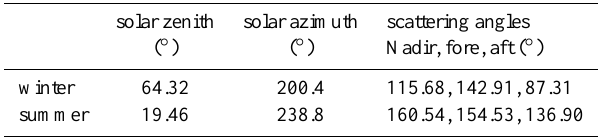
Table 2. Angles used in the simulation scenarios. Azimuth angles for the fore and aft satellite viewing are 180 ◦ and 0 ◦ , respectively (i.e., straight south and north-looking). Satellites viewing angles for those off-nadir geometries are always 30 ◦